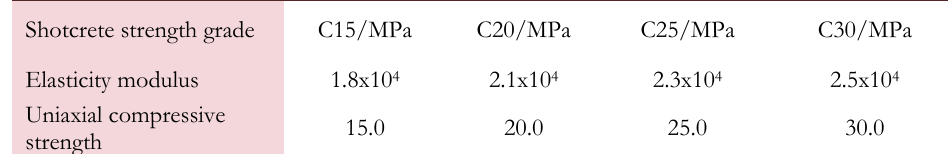
Table 5: Standard values of shotcrete elasticity modulus and uniaxial compressive